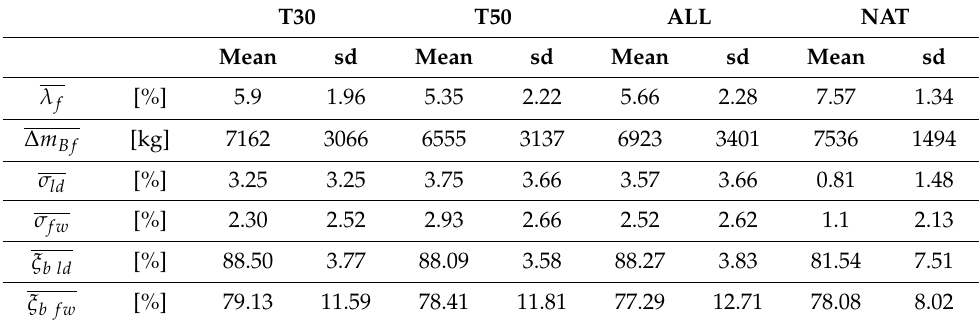
Figure 6. Histograms and mean values of the relative ( λ f ) and absolute ( ∆ m Bf ) formation efficiency metrics, detours ( σ ), relative lengths of the beneficial segment ( ξ b ) for the FXD setting; leader (orange), follower (green), combined (red); note: occurrence is shown on y-axis. Table 2. Average statistics for the different scenarios assessed in this study and the FXD